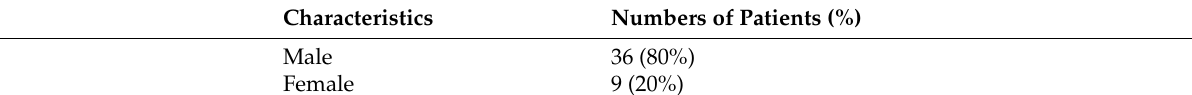
Table 1. Patient and tumor